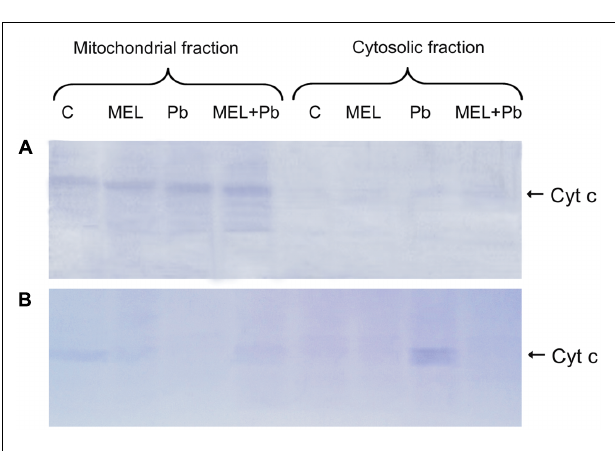
FIGURE 5 | Expression of the cytochrome c protein. (A) the 4th day – 4 h after lead administration and (B) the 6th day – 2 days after lead administration. Lysates from untreated BY-2 cells (C), cells grown on the medium supplemented with melatonin (MEL) and cells exposed to lead without and with melatonin treatment (Pb and MEL + Pb,